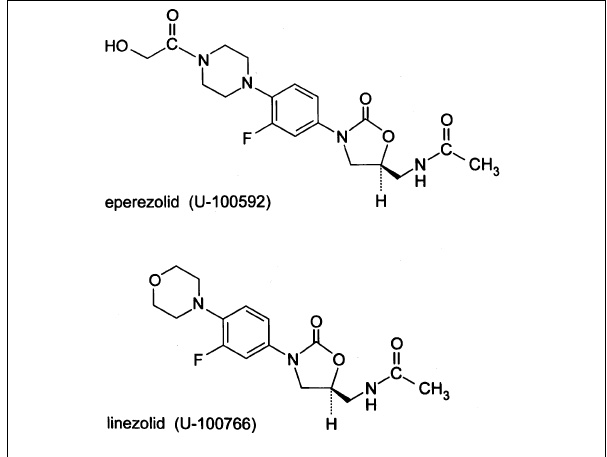
Figure 1) Chemical structure of eperezolid and